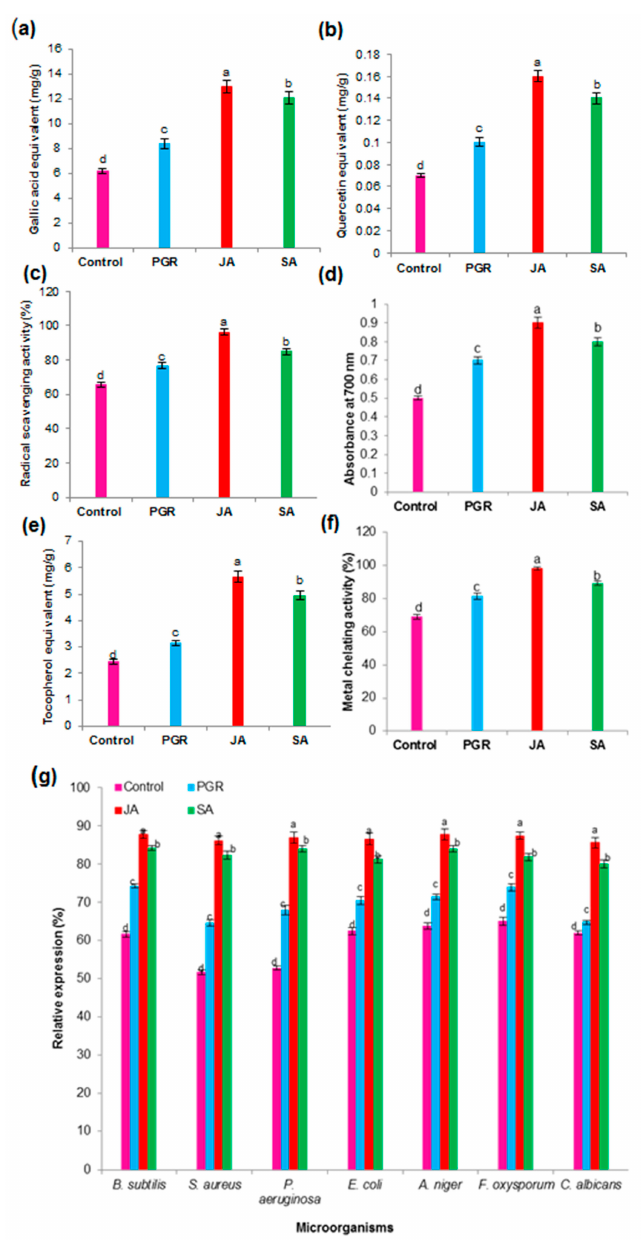
Figure 4. Effects of plant growth regulators (PGRs), JA and SA on levels of total phenolic and flavonoid content, antioxidant and antimicrobial activity in cell suspension cultures of P. multiflorum ( a ) Total phenolic content (TPC); ( b ) Total flavonoid content TFC; ( c ) Free radical-scavenging activity